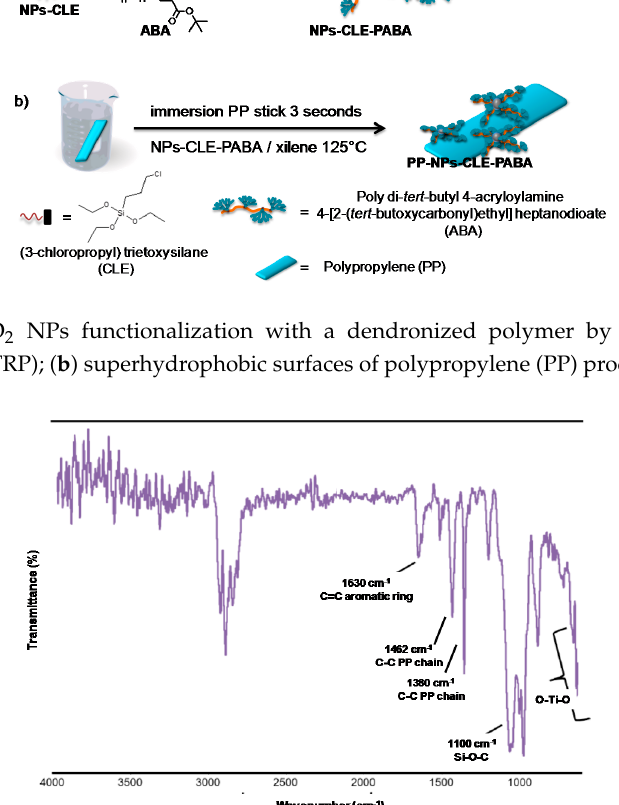
Figure 8. FT-IR spectrum of nanostructured PP with dendritic monomers.